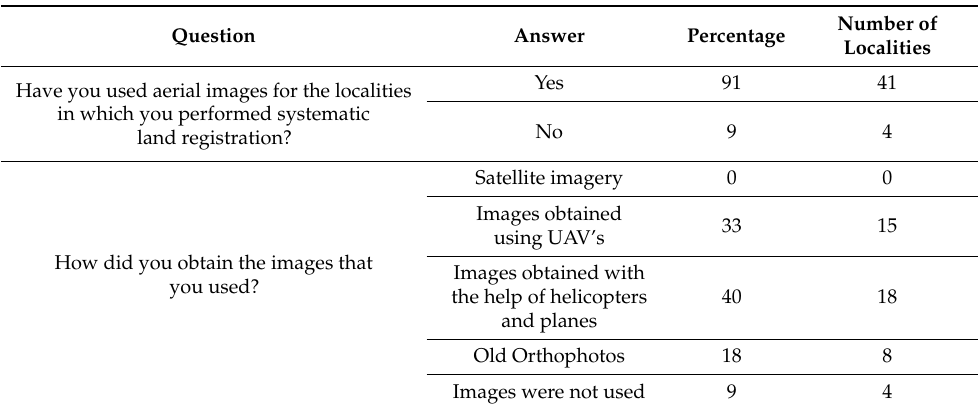
Table 4. Percentage and number of localities in which aerial images were used for systematic land registration; The way images were obtained for systematic land registration